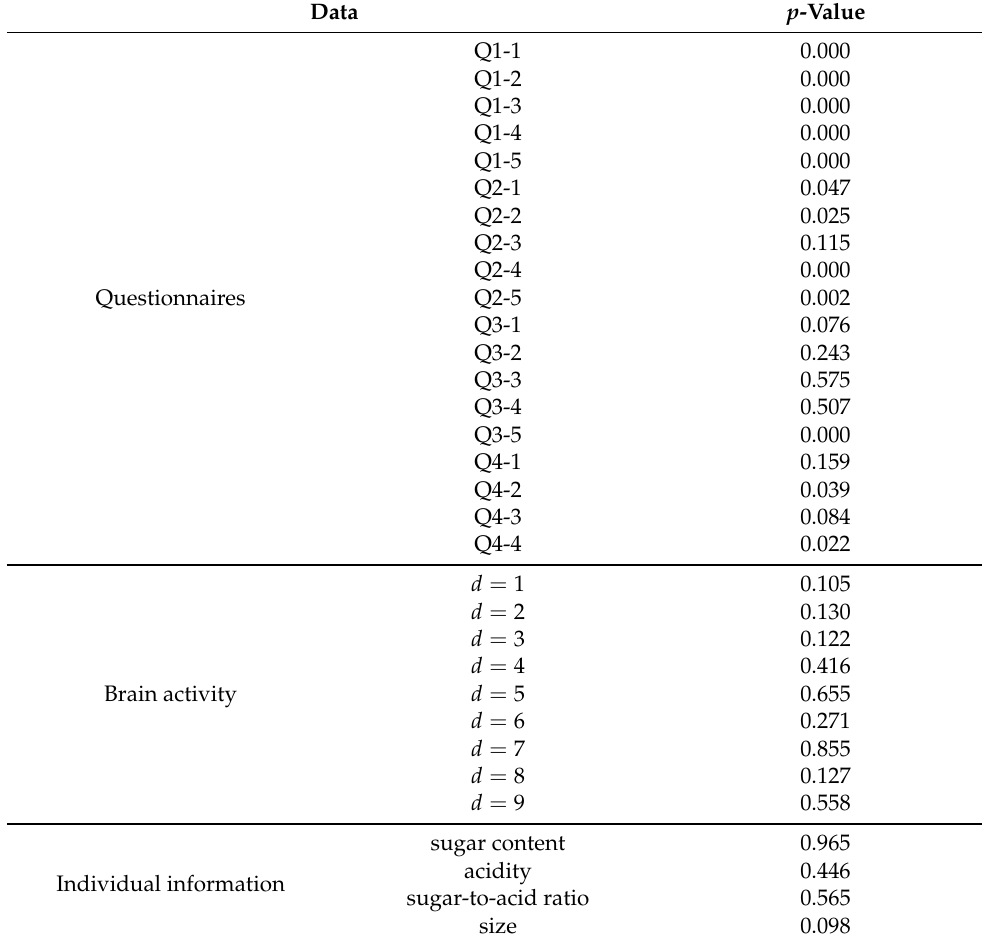
Table 4. p -value for correlation between taste and other